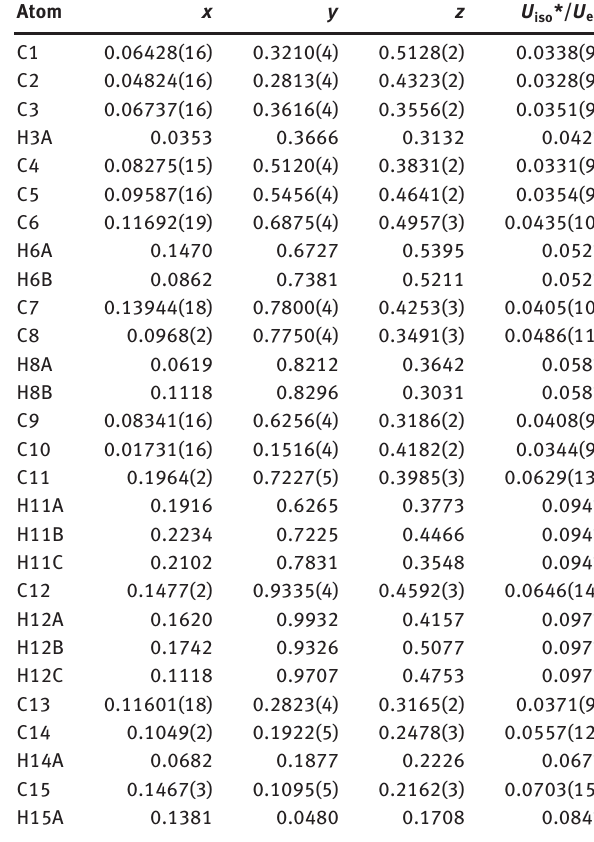
Table 2: Fractional atomic coordinates and isotropic or equivalent isotropic displacement parameters (Å 2